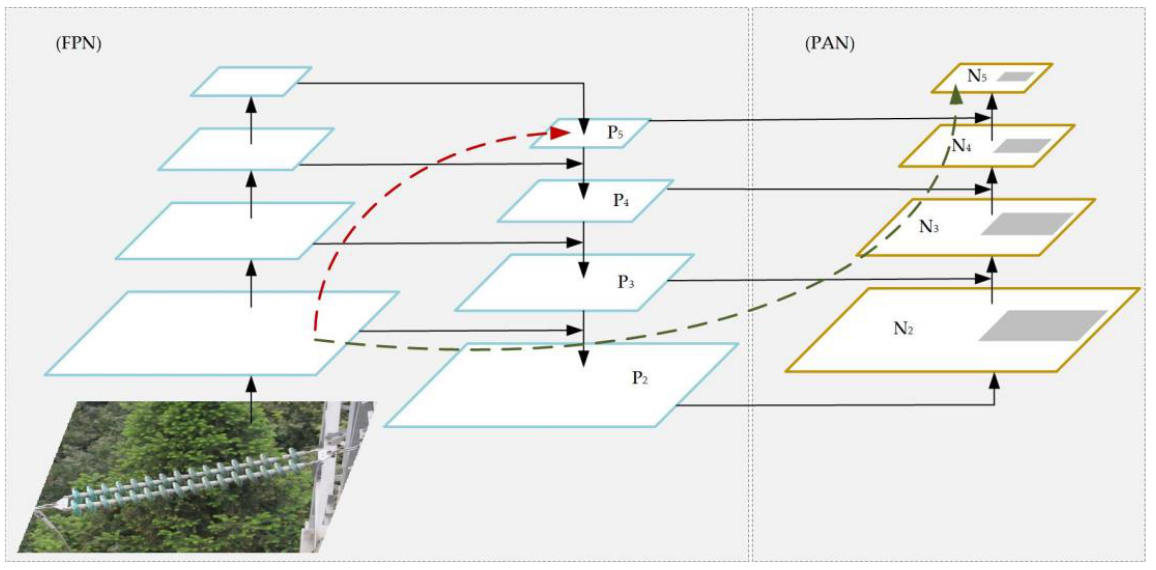
Figure 1. The neck part of ID-YOLO based on FPN and PAN. The head for predicting the object class and box position is the last part of the detector. The existing head part is divided into one-stage and two-stage. The most classic method in the two-stage class model is the R-CNN series, which first uses RPN to predict the box’s position and category roughly, then gives more accurate results through the head. The two-stage method has better detection accuracy but high time consumption. The one-stage model is based on the feature map giving the prediction result directly. Although the detection effect of the one-stage model is slightly worse than that of the two-stage method, the detection speed is significantly improved. The more classic one-stage models include YOLOv4, SSD, RetinaNet, etc., among which YOLOv4 is a method for obtaining excellent performance in speed and detection accuracy. Therefore, this article builds the head part of ID-YOLO based on